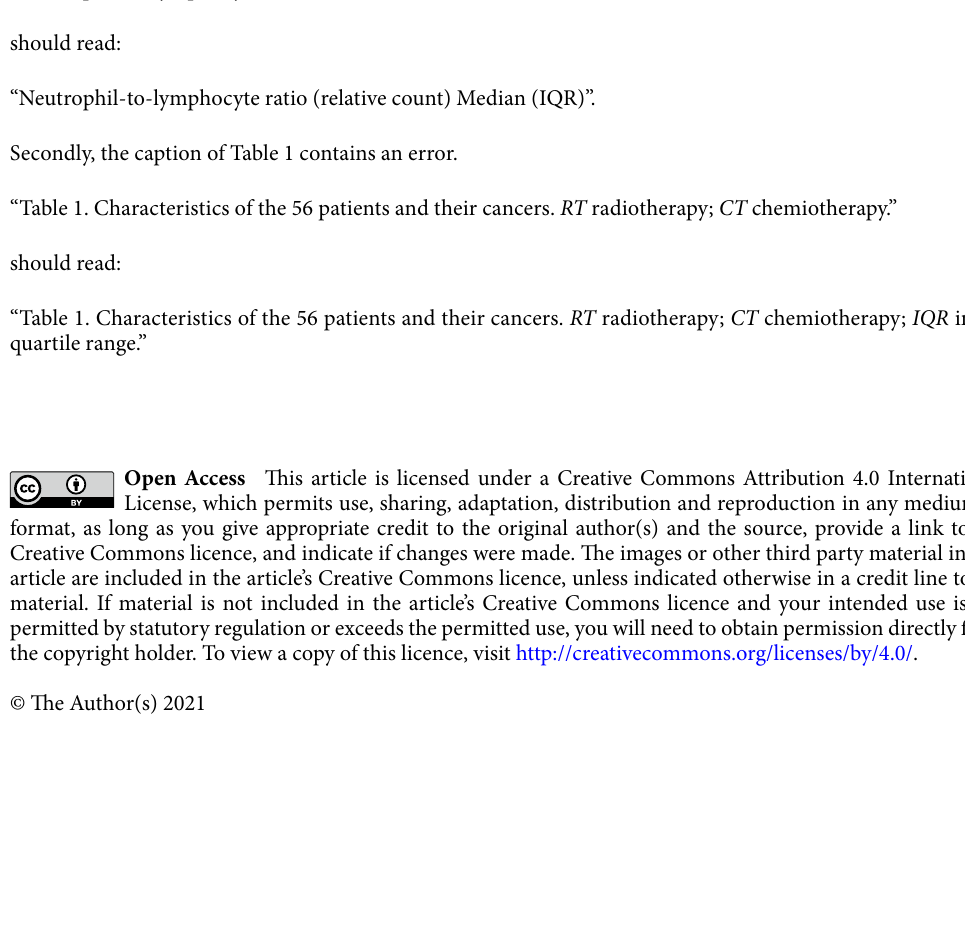
“Table 1. Characteristics of the 56 patients and their cancers. RT radiotherapy; CT chemiotherapy.” should read: “Table 1. Characteristics of the 56 patients and their cancers. RT radiotherapy; CT chemiotherapy; IQR inter- quartile